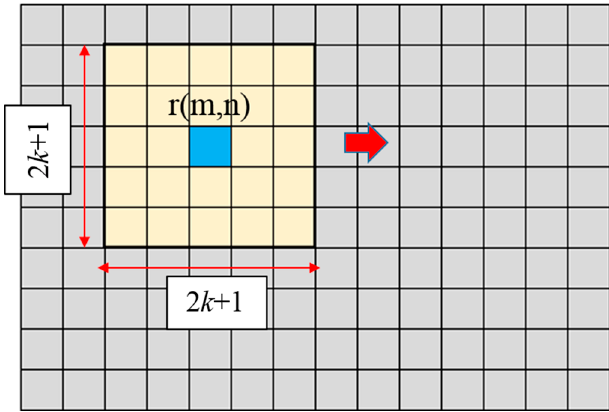
Figure 4. Schematic diagram of a sliding window.